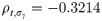
Visualization of the predictive distribution p(logΘ) transformed to the physical parameter range for AAA Pat17.Plots (I)-(VI) show 2D marginal distributions over all possible parameter combinations between t, α, β and σγ. Highest correlations are observed between t and σγ (ρt,σγ=−0.3214), β and σγ (ρβ,σγ=0.2274), t and β (ρt,β = −0.1966) as well as α and β (ρα,β = 0.1413).